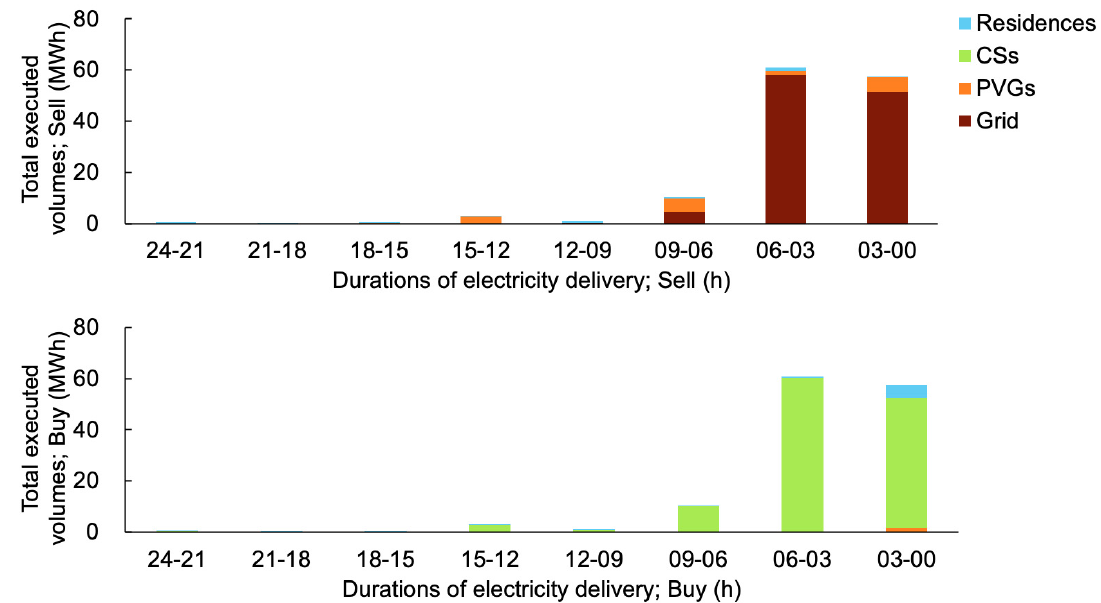
Figure 8. Total executed volumes for each duration of the electricity delivery in the target period.